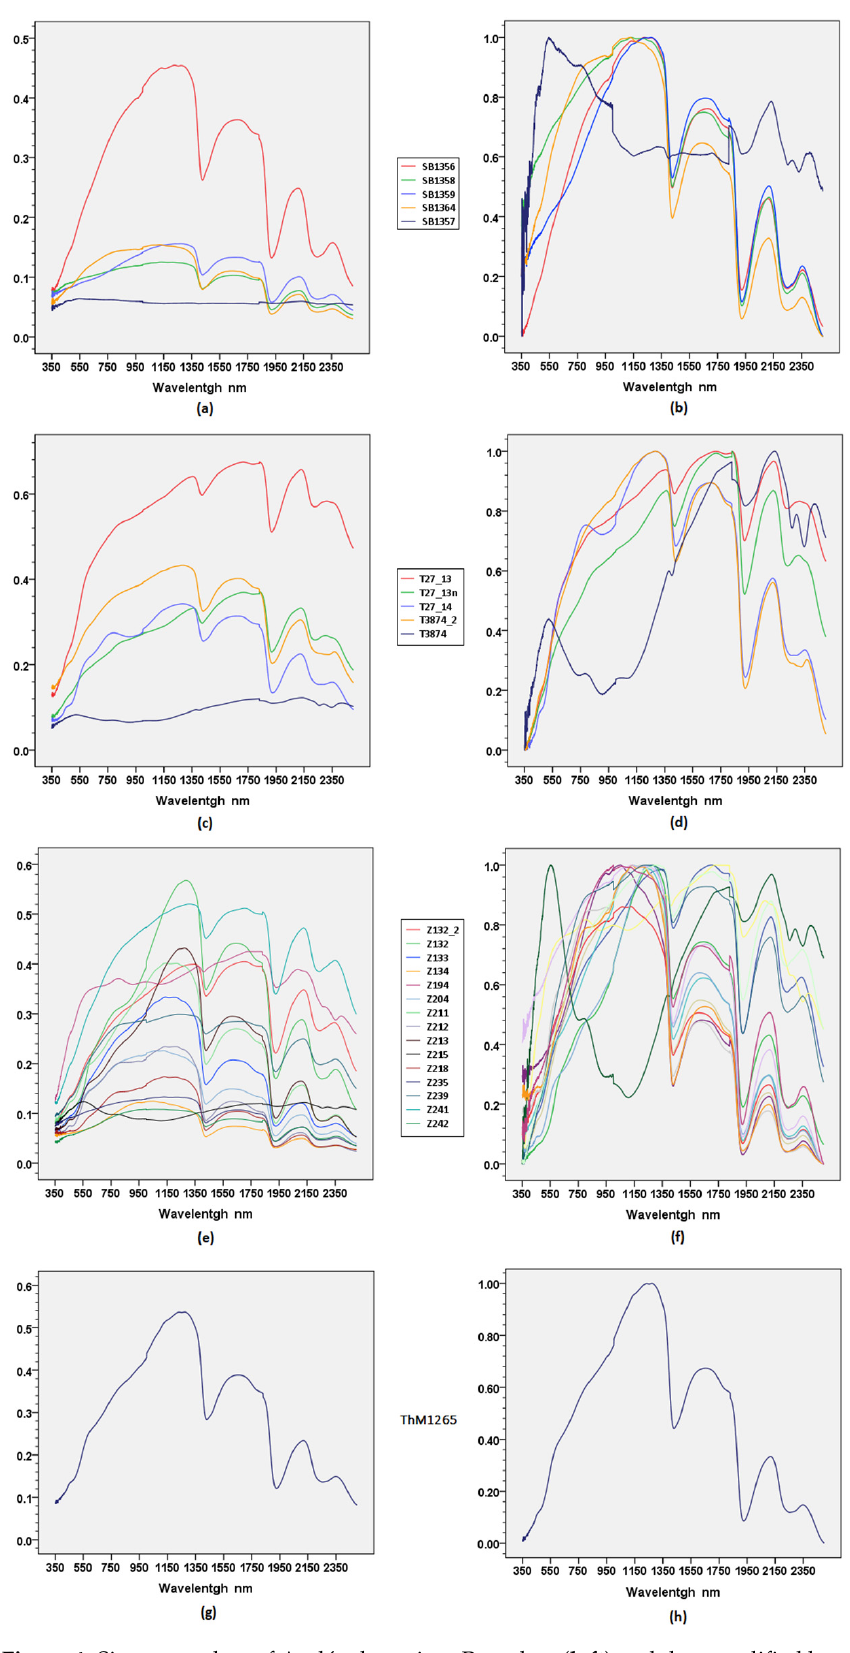
Figure 4. Signature plots of Andévalo region. Raw data ( left ) and data modified by affine transfor- mation ( right ): Dolmen of San Bartolomé ( a , b ); Dolmen of El Telar ( c , d ); Dolmen of La Zarcita ( e , f ); Tholos of El Moro ( g , h ).